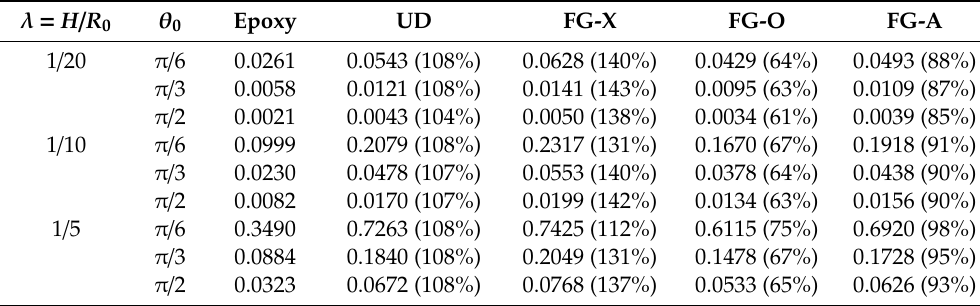
Table 5. The fundamental frequency Ω of S-S FG-GPLRC circular